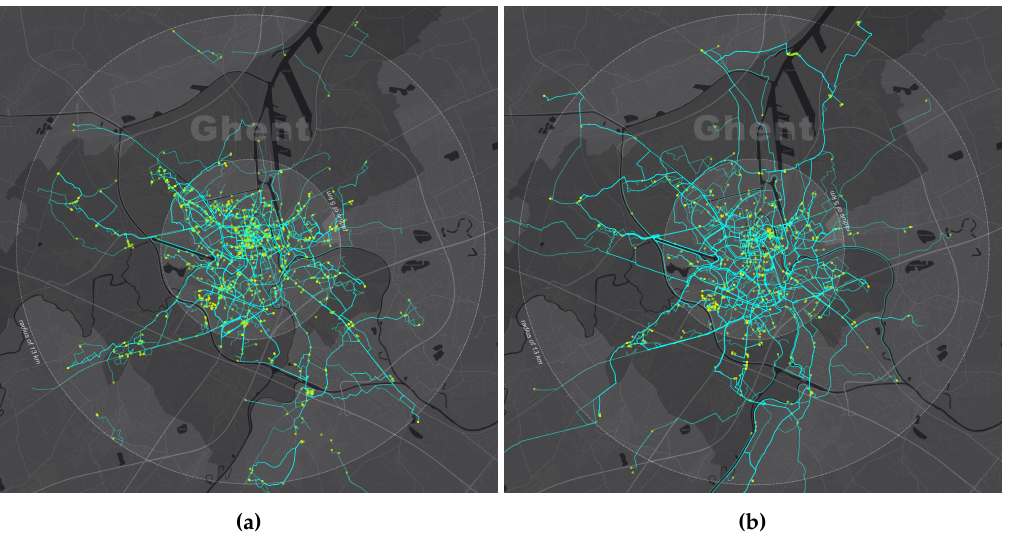
Figure 3. Morning trips during working days (destination points are shown as yellow dots): ( a ) short-range trips. ( b ) mid-range